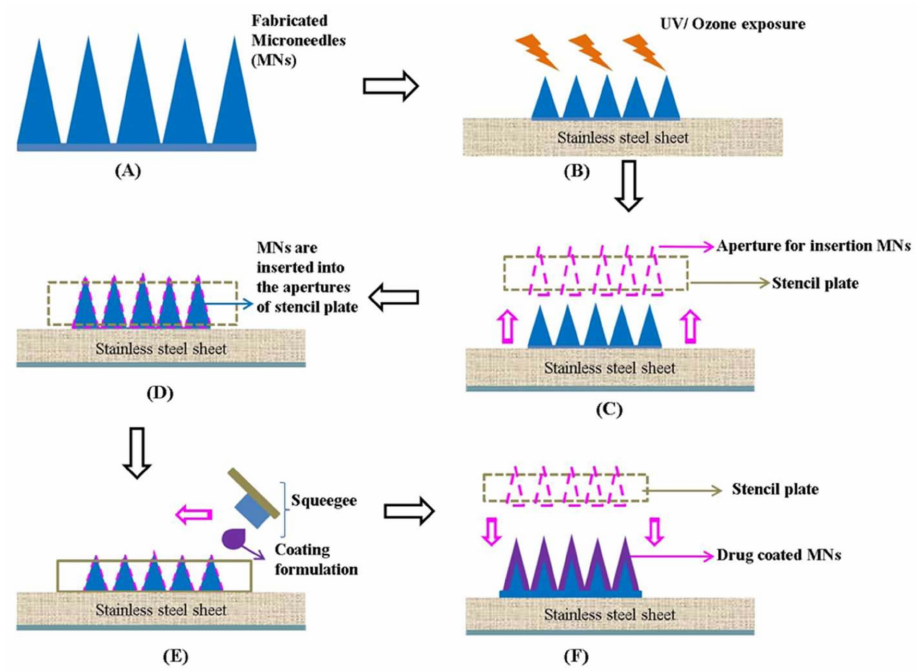
Figure 4. Drug coating of microneedles (MNs) by stencil plate method ( A ) fabricated MNs ( B ) UV/Ozone exposure of MNs ( C ) UV/ozone exposed MNs and stencil plate with apertures ( D ) insertion of MNs into the apertures of stencil plate ( E ) dropping the coating formulation and spreading it with squeegee ( F ) drug coated MNs removal from the stencil